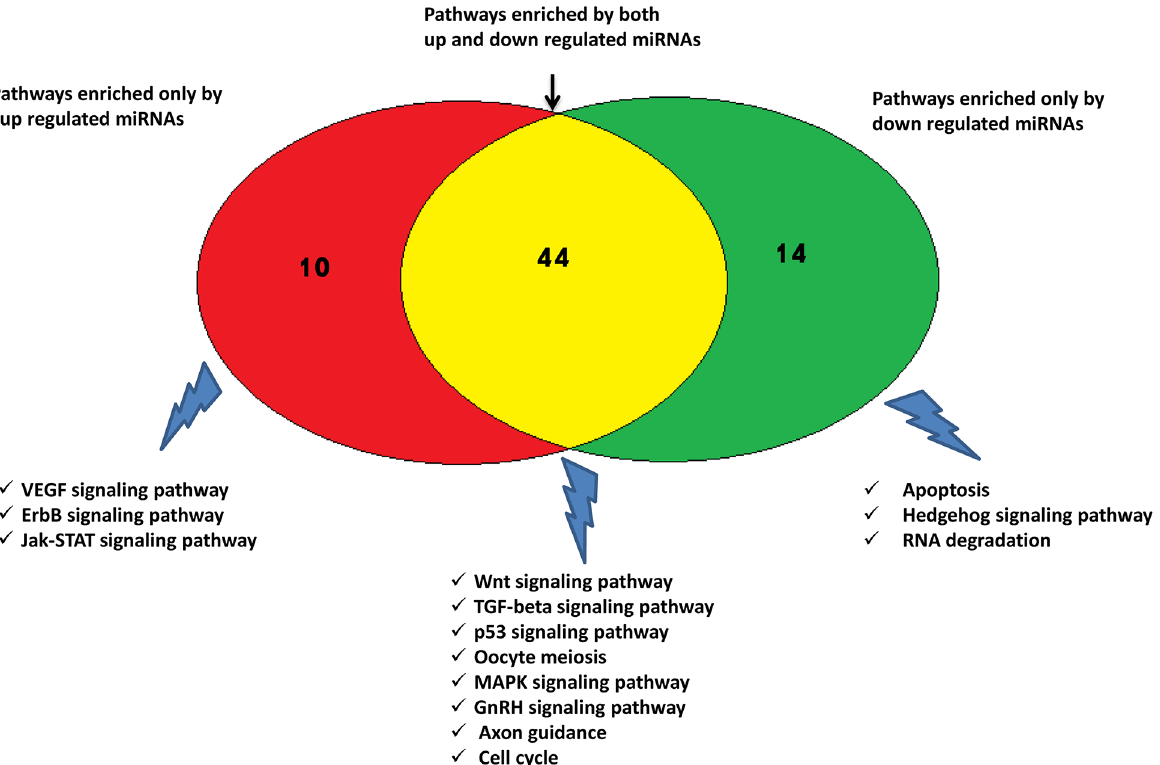
Fig 4. Venn diagram showing number of canonical pathways enriched by predicted target genes of differentially expressed miRNAs. Representative pathways enriched by predicted target of only up regulated miRNAs (red), only down regulated miRNAs (green) and both up and down regulated miRNAs (yellow) are